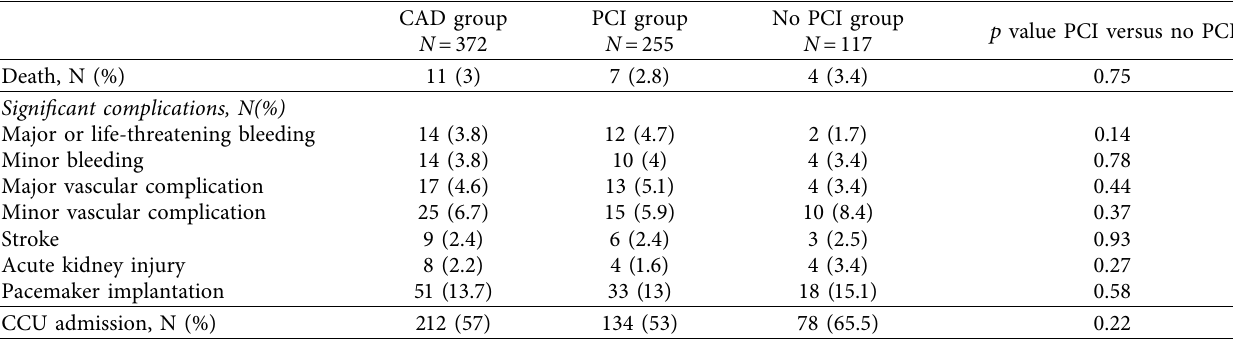
Table 5: Procedural adverse clinical outcomes in CAD-TAVI group stratified by the performance of